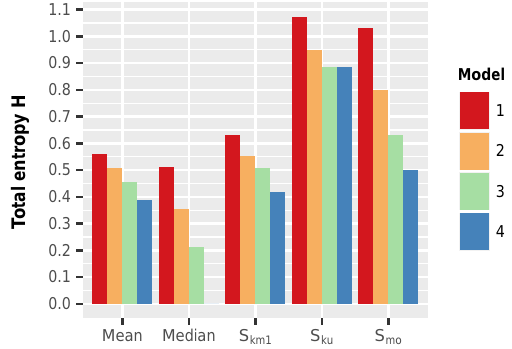
Figure 9. Average entropy H M calculated for the different mod- els (mean and median) and for subsets of the model space of each model ( S km1 , S ku , S mo